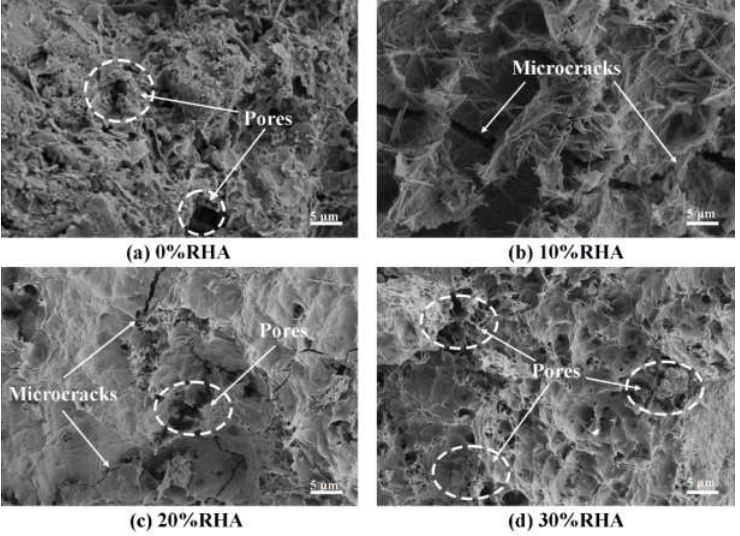
Figure 9. Microscopic morphology of the paste samples with different RHA replacement ratios after the freeze–thaw cycles.